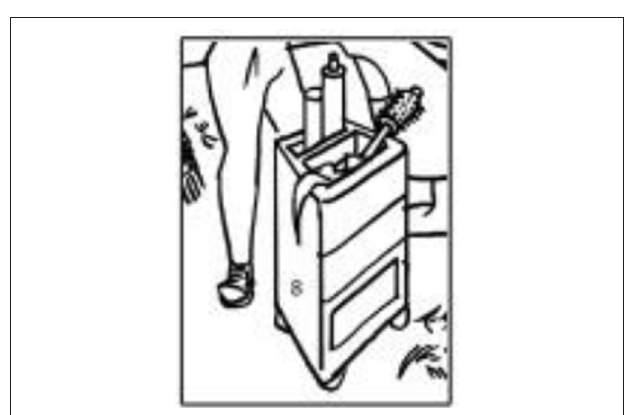
FIGURE 9 | Tray table.